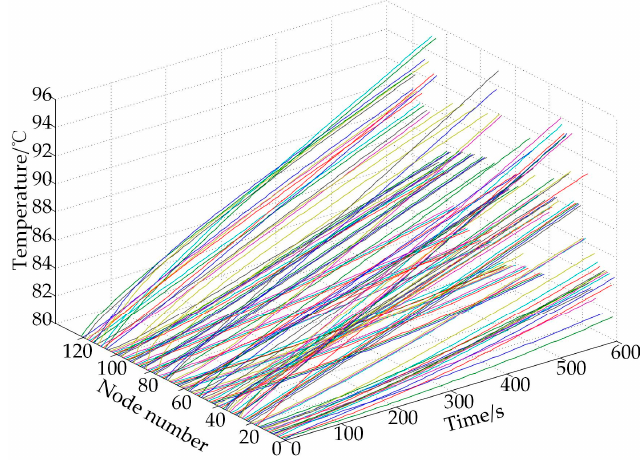
Figure 14. Node temperature of the 80 °C-300 rpm-6 Nm mode.